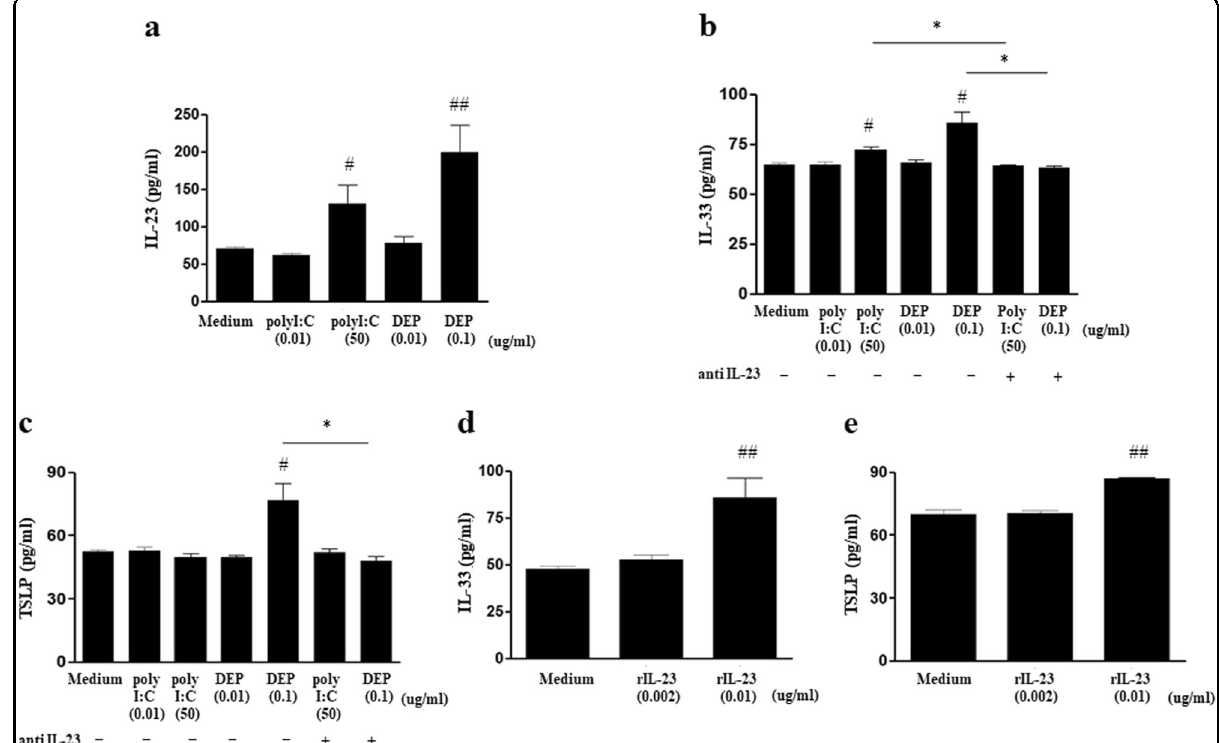
Fig. 5 Effect of polyI:C, DEP, and rIL-23 treatments on MLE12 cells. a IL-23 production by MLE12 cells treated with different doses of polyI:C or DEP. b IL-33 production by MLE12 cells treated with different doses of polyI:C or DEPs, with or without anti-IL-23 antibodiesy. c TSLP production by MLE12 cells treated with different doses of polyI:C or DEPs, with or without anti-IL-23 antibodies. d IL-33 production by MLE12 cells treated with different doses of rIL-23. e TSLP production by MLE12 cells treated with different doses of rIL-23. * P < 0.05 between two groups; # P < 0.05, ## P < 0.01 compared to medium only; DEP diesel exhaust